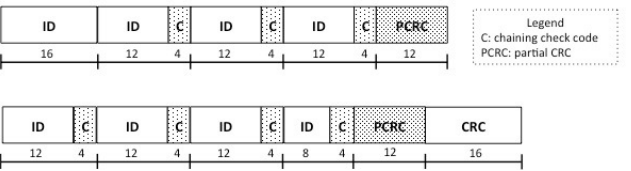
Figure 1. Example of EPC ID partitioning into multiple blocks and related check